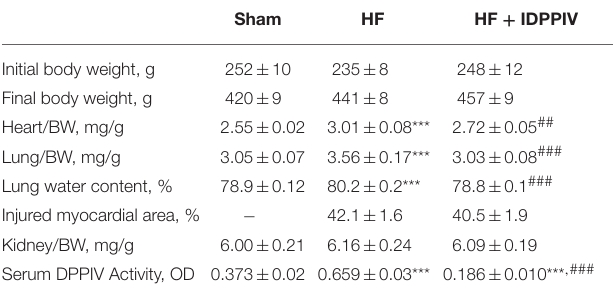
TABLE 1 | Biometric parameters and serum DPPIV activity in sham and HF rats treated with vehicle (HF) or vildagliptin for 4 weeks.